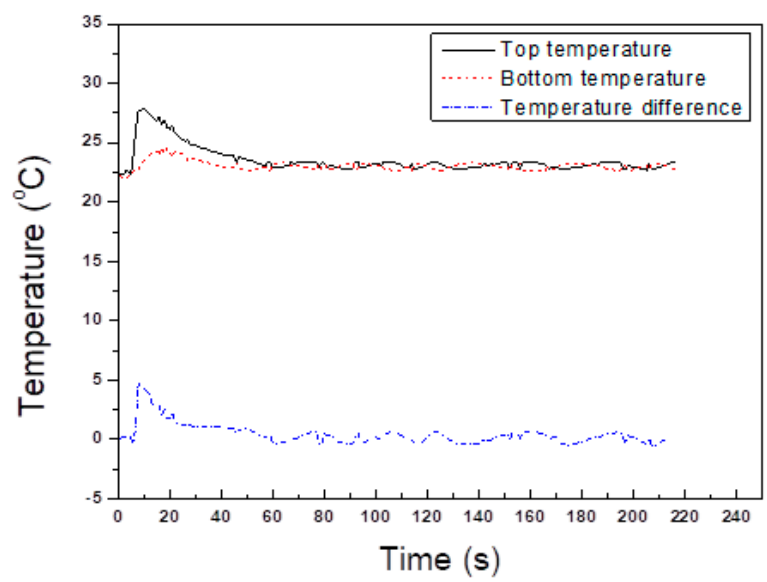
Figure 6. Typical example of the thermal pulse disturbance for the decision of mixing time. 20 vol% glycerin and 110 rpm shaking frequency.